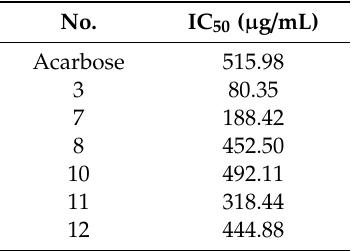
Table 8. α -glucosidase activity inhibition test results.